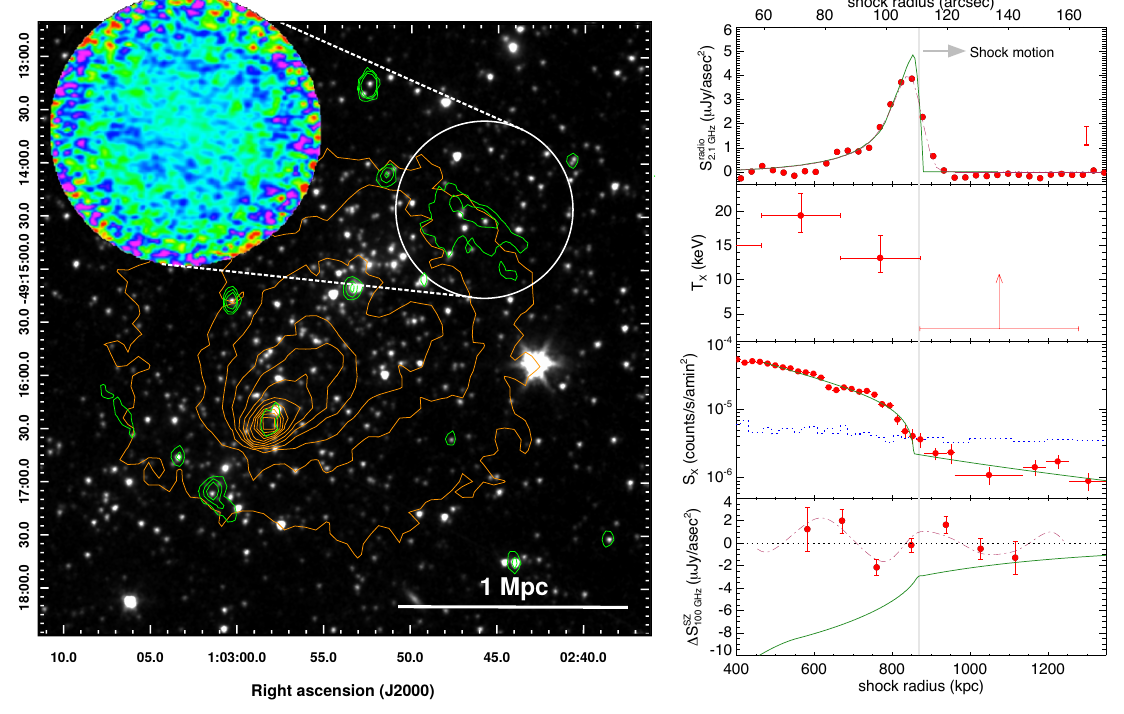
Figure 5. A relic shock in the El Gordo cluster at z = 0.87 (from [16]). Left: Multi-wavelength view of the El Gordo cluster and its NW relic. The background image is a Spitzer IRAC mosaic at 3.6 µm, and the orange and green contours mark the Chandra X-ray 0.5–2 keV emission and the ATCA 2.1 GHz radio emission, respectively. The observed SZ intensity distribution from an ALMA deconvolved image is shown in the zoomed-out inset. Right: Thermal and non-thermal signal variations across the relic shock. Shown here from top are the 2.1 GHz radio synchrotron profile, the Chandra X-ray temperature measurements, the X-ray brightness profile across the relic, and the ALMA SZ measurement together with the best fit shock model (green